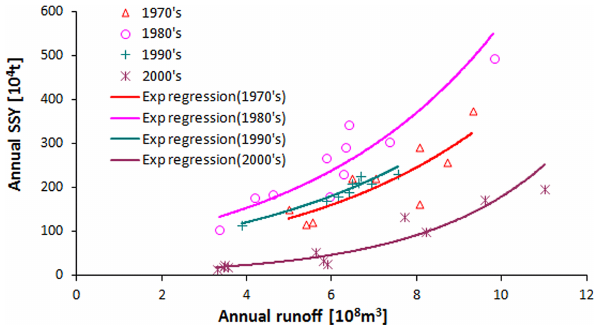
Figure 3. The relationship between annual runoff and suspended sediment yield at the outlet of the Kejie watershed (1971–2010).